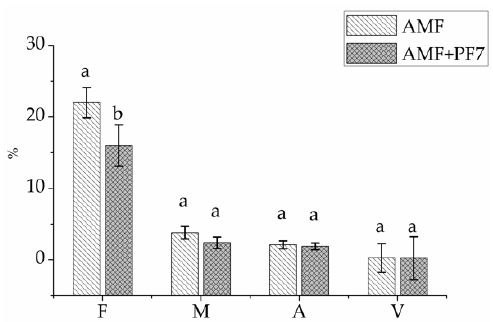
Figure 5. Mycorrhizal colonization in absence/presence of PF7 on mesocosms. Different letters indicated that the differences among the means were significant (p-value <0.05).